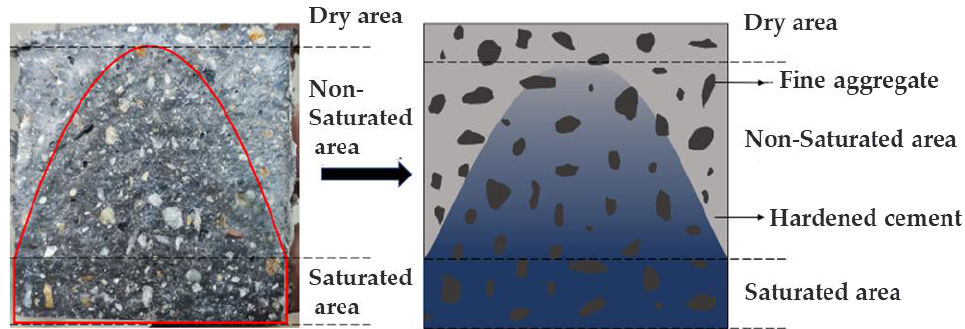
Figure 8. The capillary water distribution in the section of 1/2 length of the specimen (after 36 days of capillary water absorption).